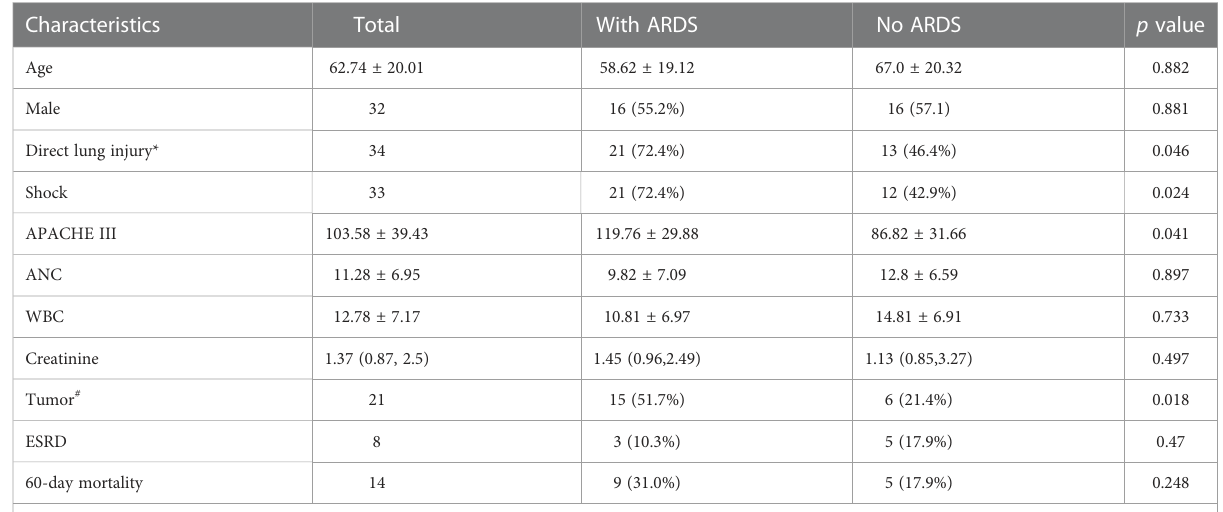
TABLE 1 Baseline characteristics, laboratory parameters and clinical outcomes strati fi ed by the ARDS occurrence.